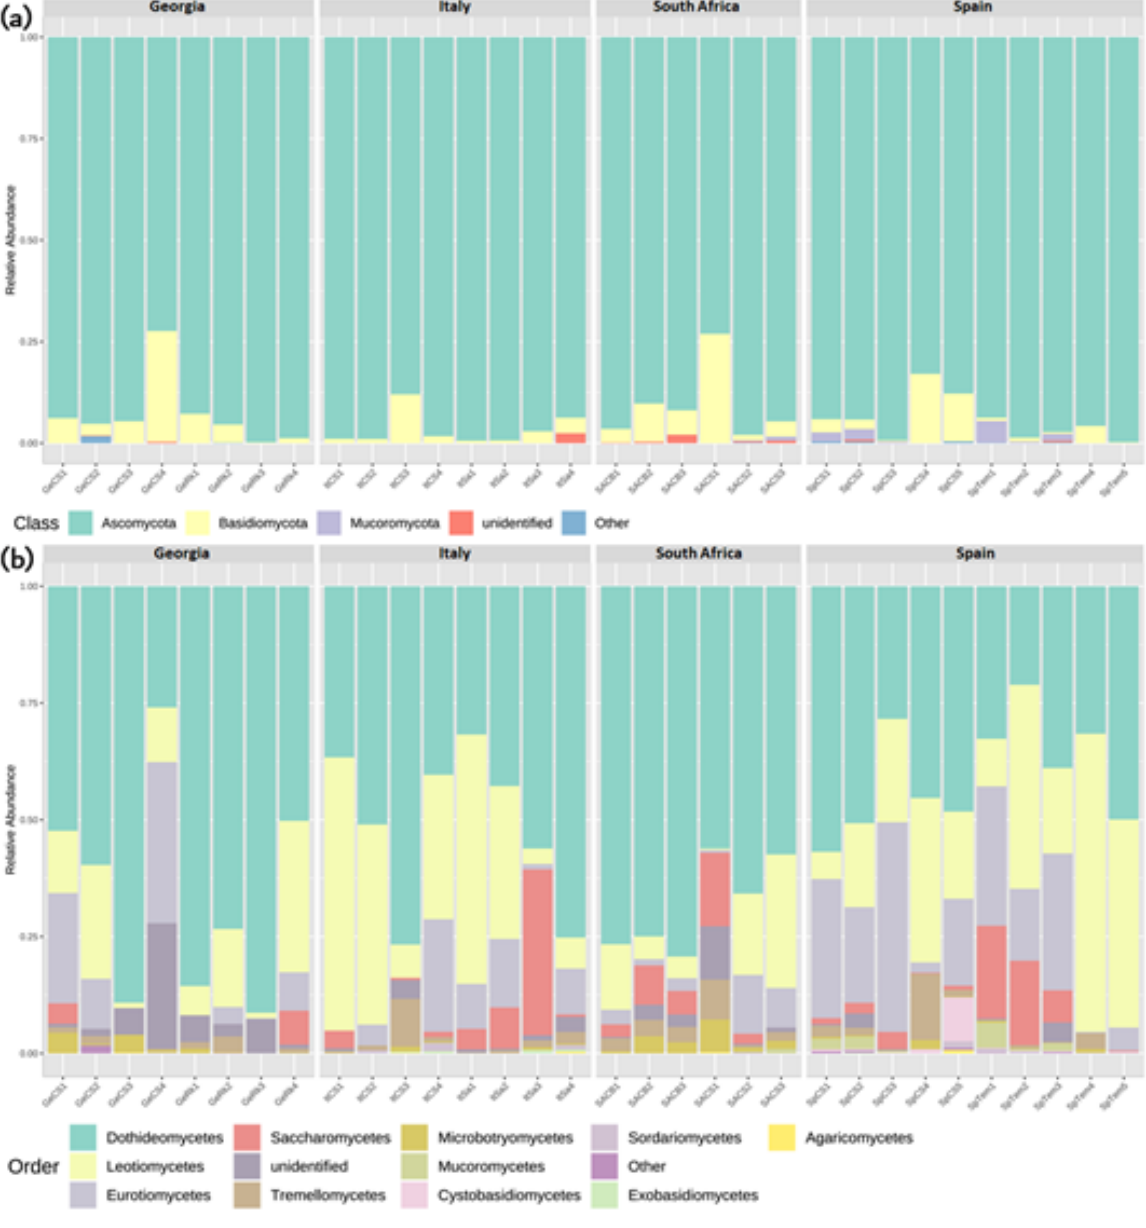
Figure A2. Relative abundance of classes and orders in the samples of the four countries: ( a ) distribution of classes; ( b ) distribution of orders.